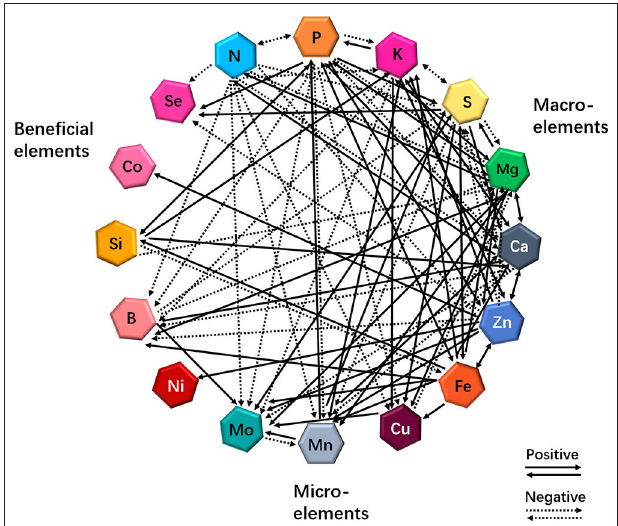
FIGURE 1 | Cross-talks between macro- and micro-elements or beneficial elements in plants in response to individual mineral deficiency. Interactions resulting from single-element deficiency (any one of 16 elements) lead to enhanced (solid lines) or decreased (dashed lines) uptake of other minerals. Updated from the previous publications ( Bokor et al., 2015; Rai et al., 2015; Maillard et al., 2016; Courbet et al., 2019; Chaiwong et al., 2020; Zhou et al., 2020; Ji et al., in press